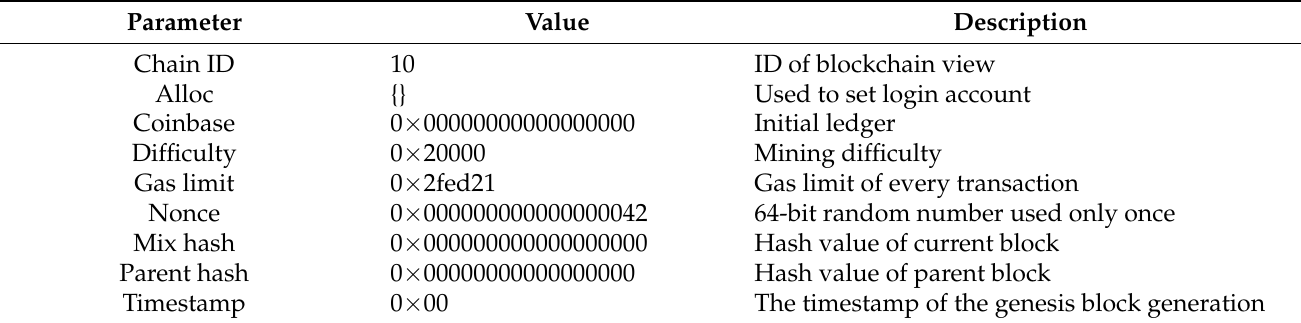
Table 1. Parameters and descriptions of genesis block.